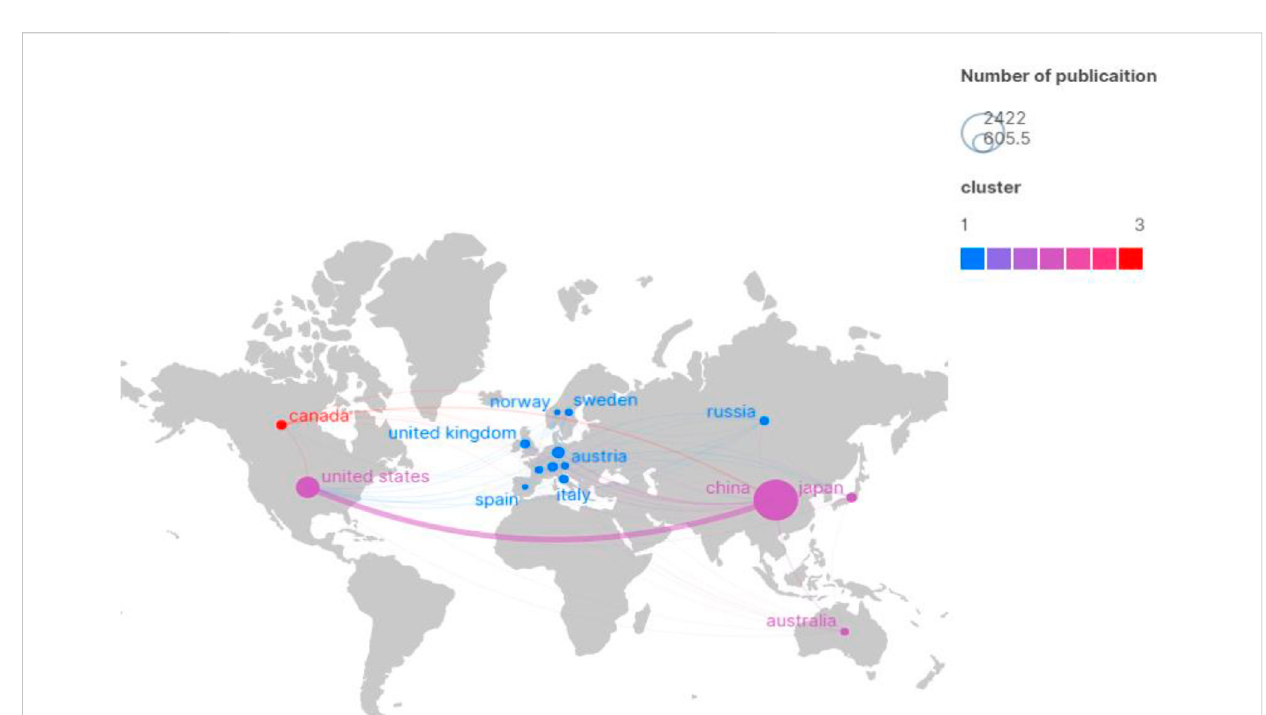
FIGURE 12 Geographical visualization analysis of inter-country cooperation relations of co-cited